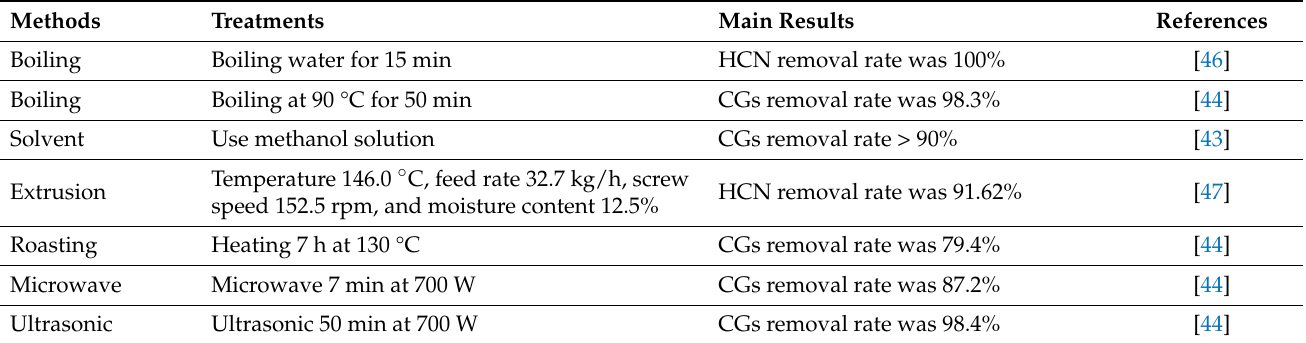
Table 2. Effect of physicochemical method on cyanogenic glycoside (CGs) in flaxseed meal.